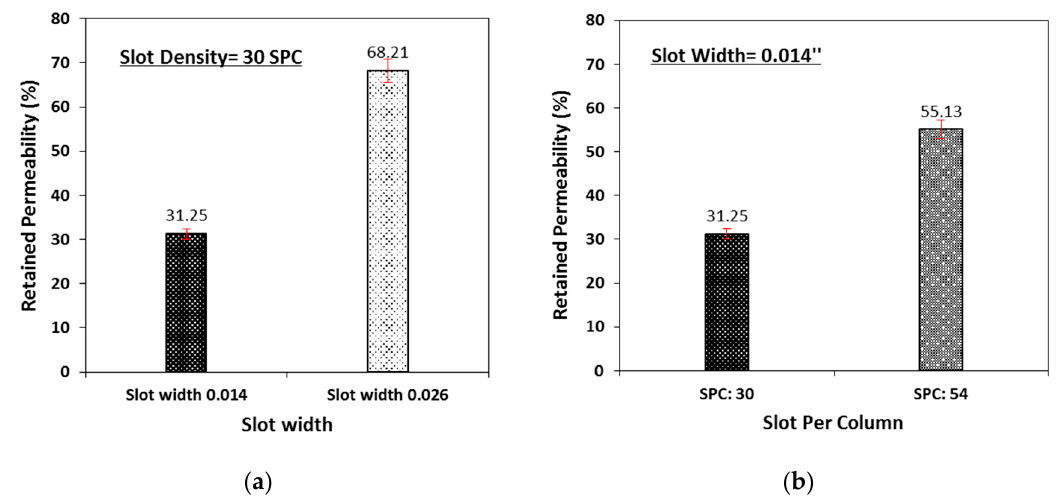
Figure 10. ( a ) Effect of slot width on retained permeability, ( b ) effect of slot density on retained Figure 10. ( a )Effectofslotwidthonretainedpermeability, ( b permeability.